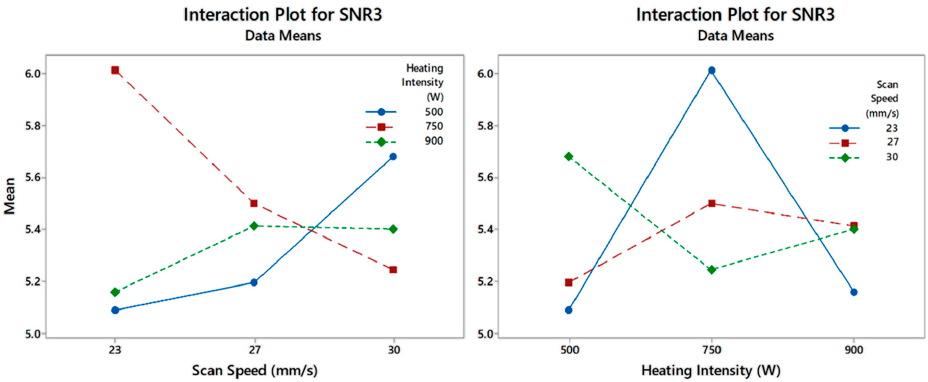
Figure 6. Interaction analyses for scanning speed and the heating intensity.